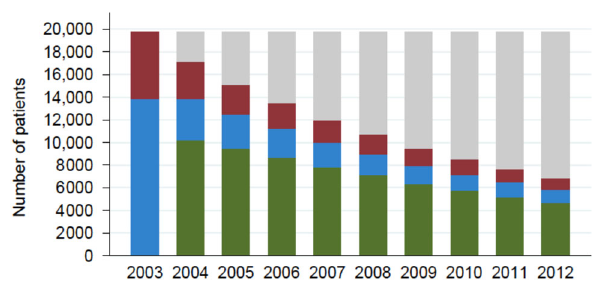
Fig. 1 Distribution of exacerbators over time. Histogram 1 illustrates the number of frequent exacerbators, infrequent exacerbators and non-exacerbators each year among exacerbators at baseline (2003). Red Frequent exacerbators ( ≥ 2 exacerbations in the given year); Blue Infrequent exacerbators (1 exacerbation in the given year); Green Non-exacerbators (0 exacerbations in the given year); Grey Lost